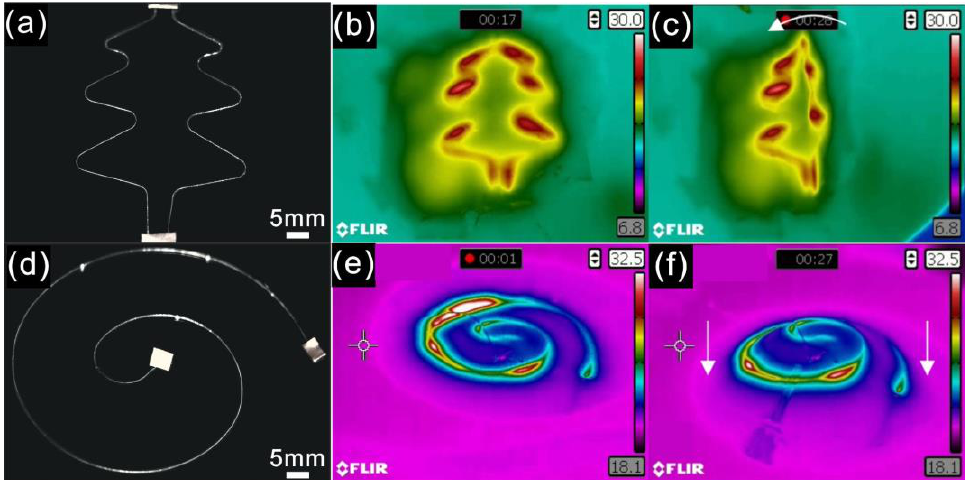
Figure 11. Printed structures with different diameters of liquid alloy: ( a ) printed tree structure heating device; ( b ) infrared thermography of tree structure heating device when applied voltage is 2 V; ( c )